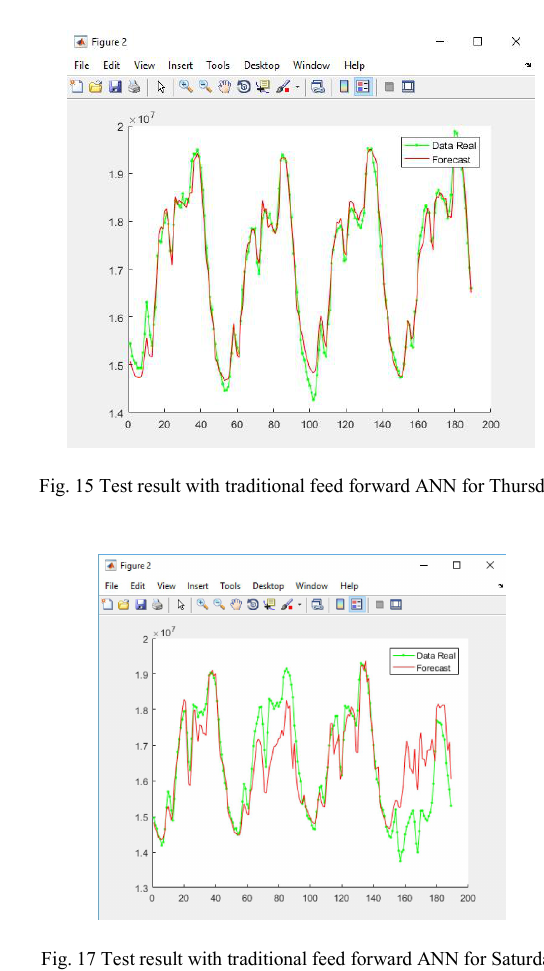
Fig. 16 Test result with traditional feed forward ANN for Friday Fig. 17 Test result with traditional feed forward ANN for Saturday